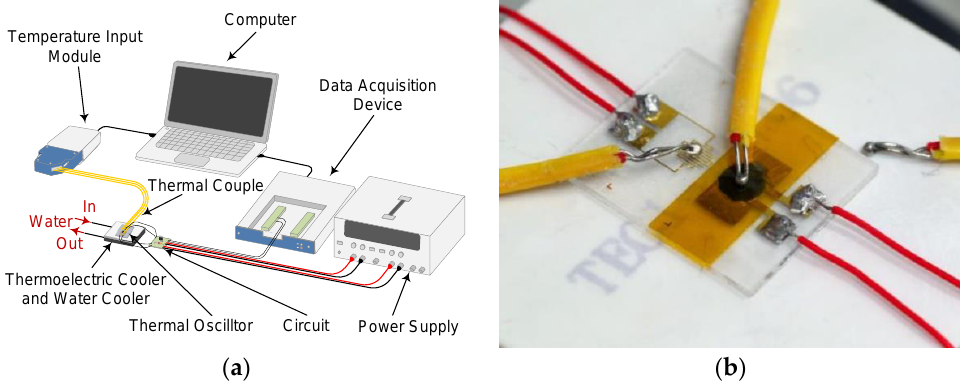
Figure 6. ( a ) Illustration of experimental setup. ( b ) Measurement of the thermal oscillator with thermocouples and cooler.